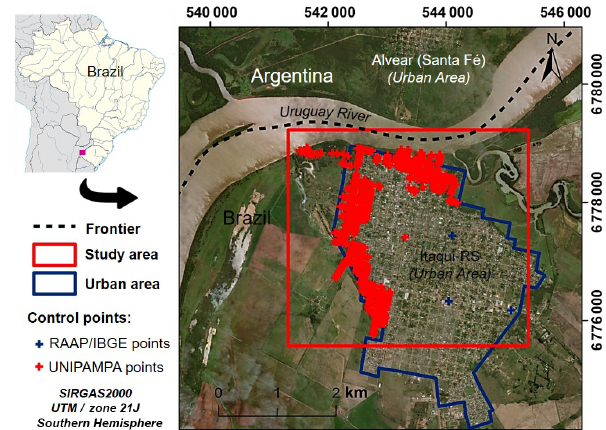
Figure 1. Location of the study area. Highlighted are the ground control points of high vertical accuracy from the High Accuracy Altimeter Network (in Portuguese, Rede Altimétrica de Alta Pre- cisão – RAAP) of the Brazilian Institute of Geography and Statis- tics (IBGE) and from the Federal University of Pampa (UNI-